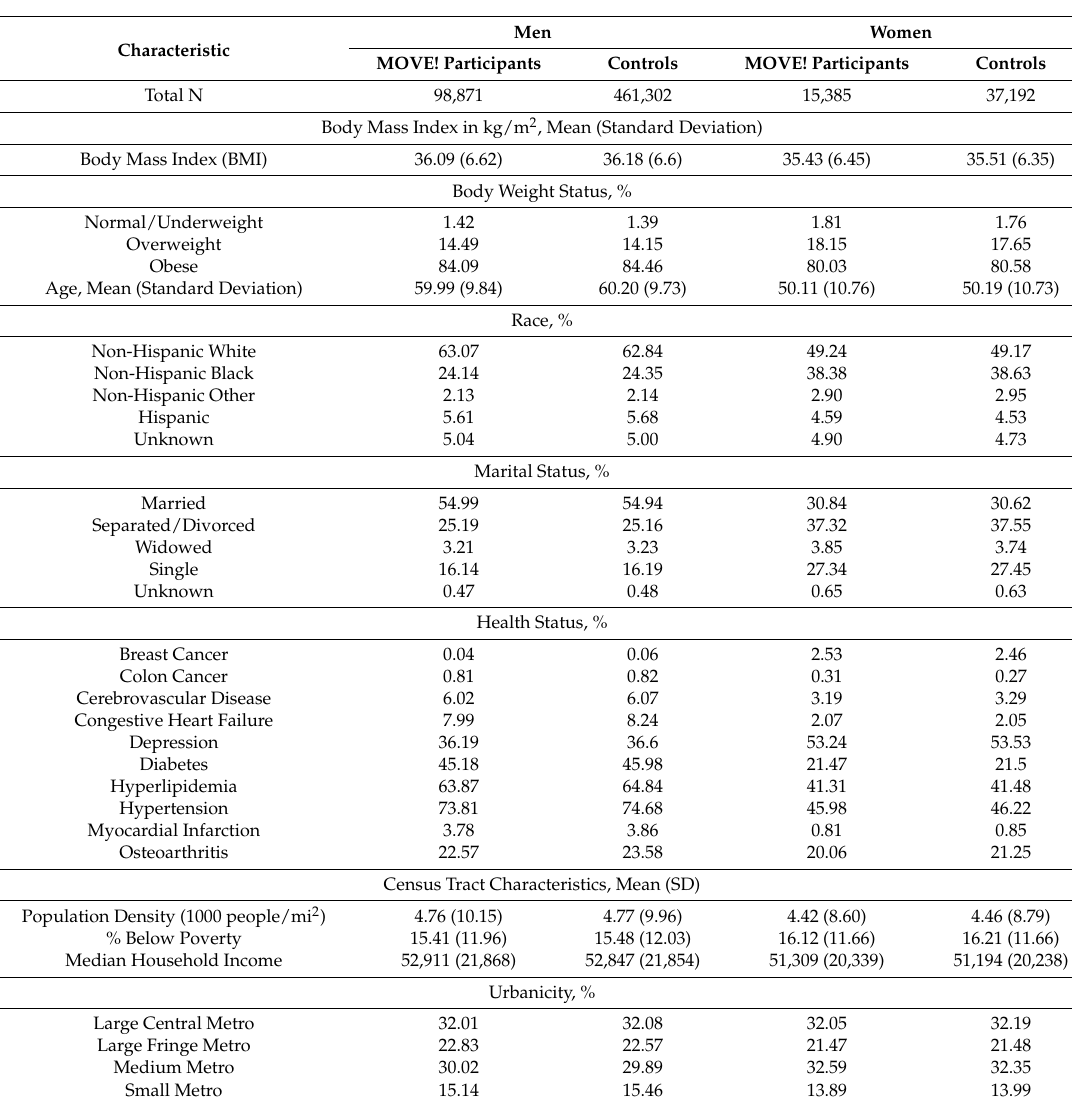
Table 1. Propensity score weighted descriptive statistics of sample characteristics at baseline for MOVE! participants and